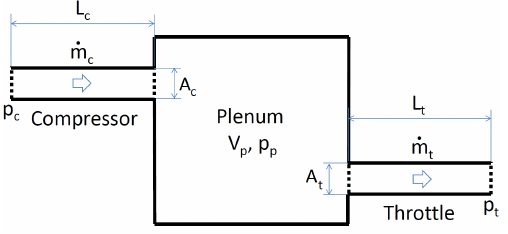
Figure 1. Compressing system in Greitzer model